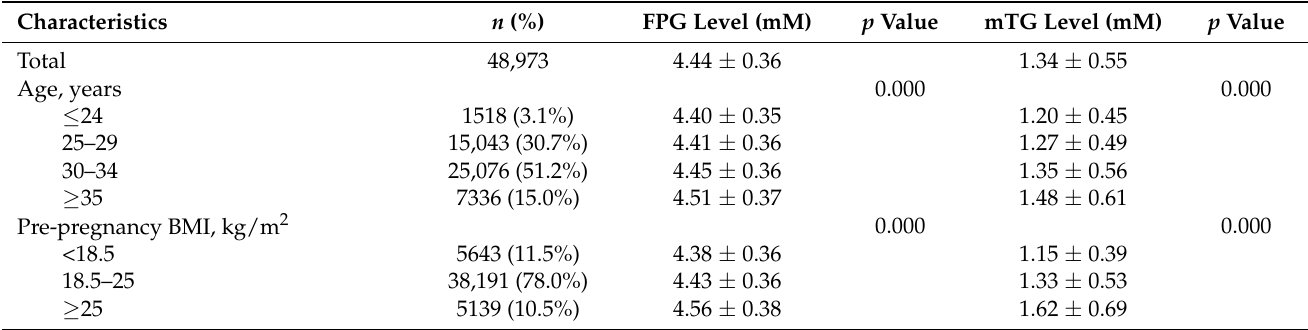
Table 1. Maternal characteristics and pregnancy complications baseline data of the study